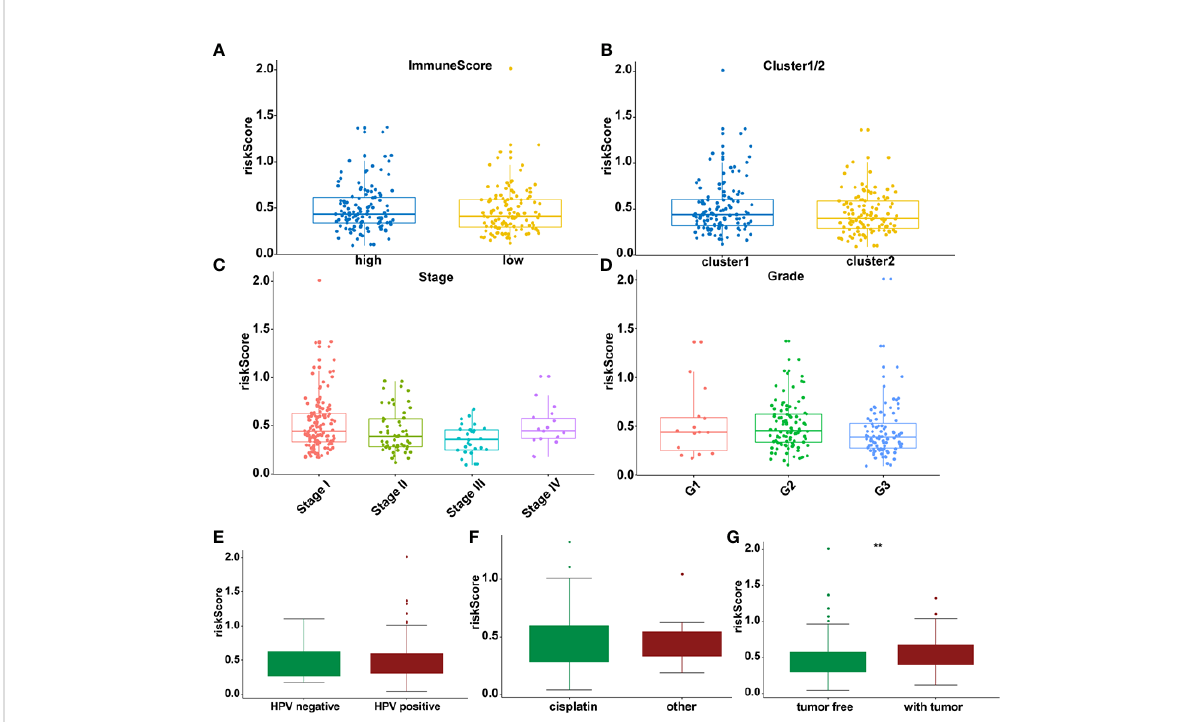
FIGURE 9 The relationship between riskscore and immunescore (A) , cluster 1/2 (B) , TNM staging (C) , grade (D) , HPV (E) , cisplatin (F) , and tumor stage (G) **p <